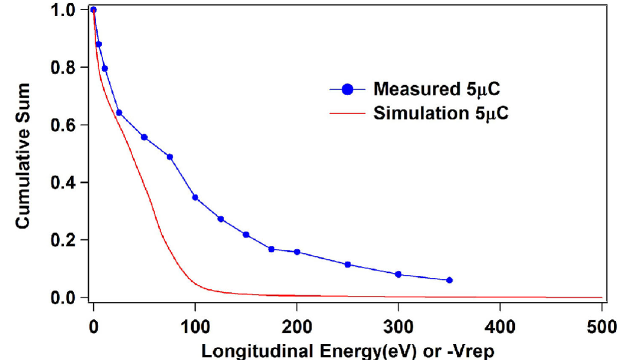
.FIG. 10. (Color) Prompt electron cumulative longitudinal en- ergy spectrum from the quadrupole diagnostic for a beam intensity of 5 (cid:1) C = pulse . The abscissa for the measured distri- bution is (cid:5) Vrep (repeller voltage) and the curve is normalized to 1 at Vrep (cid:7) 0